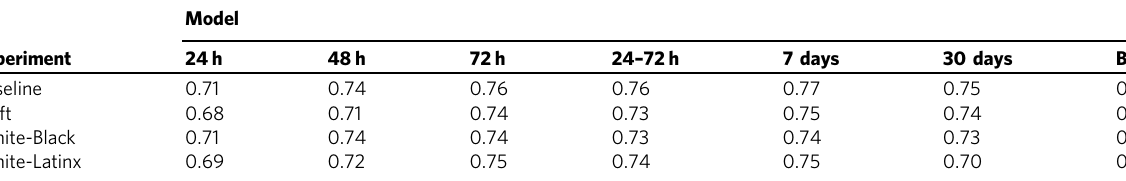
Table 6 Readmission models: impact of drift and ethnicity. Model